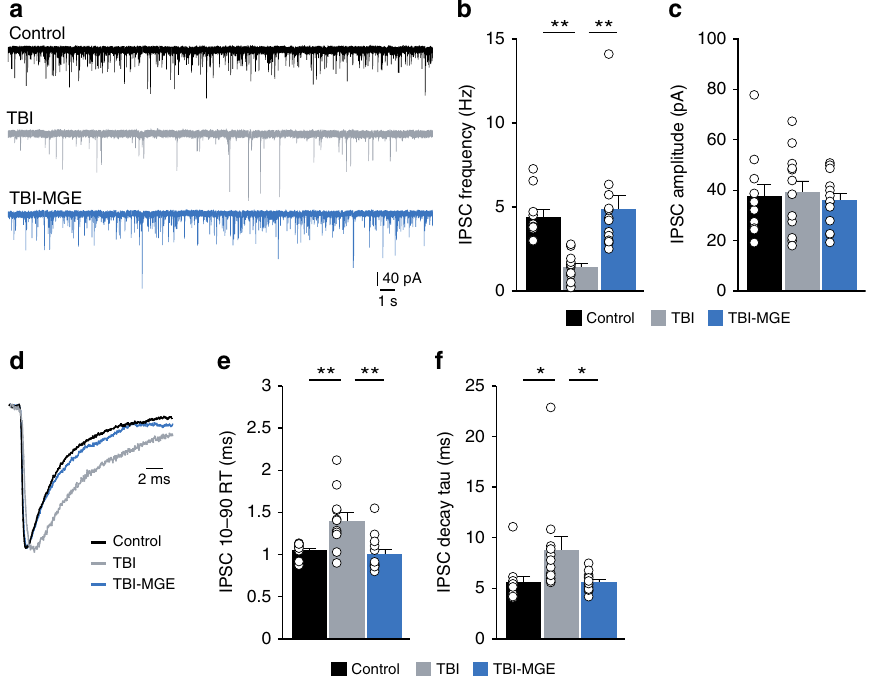
Fig. 3 MGE transplantation increases synaptic inhibition after brain injury. a Representative patch-clamp recordings of IPSCs from granule cells in a control (black), a brain injured mouse injected with media (TBI, gray) or a brain injured mouse implanted with MGE cells (TBI-MGE, blue). Recordings were obtained from slices 45 – 60 DAT. b Quanti fi cation of IPSC frequency. ** P = 0.004, control vs TBI; ** P = 0.0005, TBI vs TBI-MGE; one-way ANOVA with Bonferroni post hoc test. n = 11 cells from 3 control mice, 12 cells from 3 TBI mice and 13 cells from 3 TBI-MGE mice. c Quanti fi cation of IPSC amplitude. d Averaged IPSCs recorded from granule cells in a control mouse (black) and TBI mice receiving media injections (gray) or MGE cells (blue). e Quanti fi cation of IPSC 10 – 90% rise time (RT). ** P = 0.003, control vs TBI; ** P = 0.0006, TBI vs TBI-MGE; one-way ANOVA with Bonferroni post hoc test. f Quanti fi cation of IPSC decay time constant. * P = 0.04, control vs TBI; * P = 0.04, TBI vs TBI-MGE; one-way ANOVA with Bonferroni post hoc test. See Supplementary Table 1 for statistical analyses. Error bars, s.e.m. Source data are provided as a Source Data fi